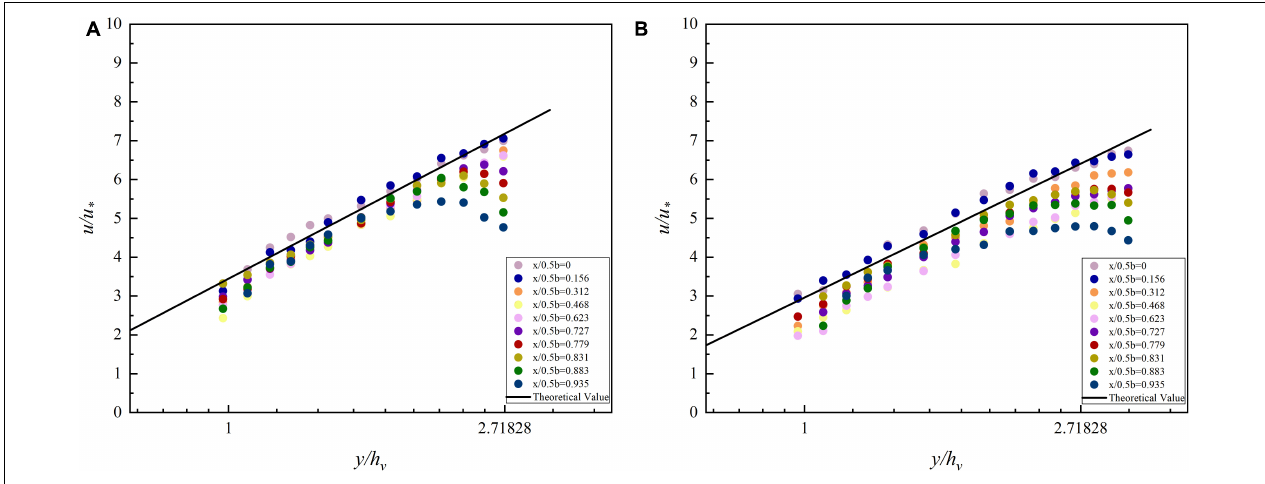
FIGURE 5 | Flow velocity distribution of different velocity measurement plumb lines in vegetated open channel cross sections. (A) 90 m 3 /h, (B) 110 m 3 /h.